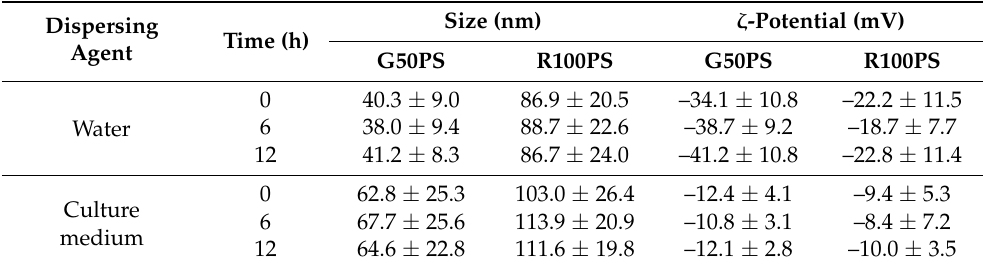
Figure 1. TEM images of G50PS (a) and R100PS (b) and the corresponding particle size statistics of G50PS (c) and R100PS (d) . G50PS ( c ) and R100PS ( d ). Table 1. Hydrodynamic sizes and ζ -potentials of G50PS and R100PS in aqueous Table 1. Hydrodynamic sizes and ζ -potentials of G50PS and R100PS in aqueous solutions.